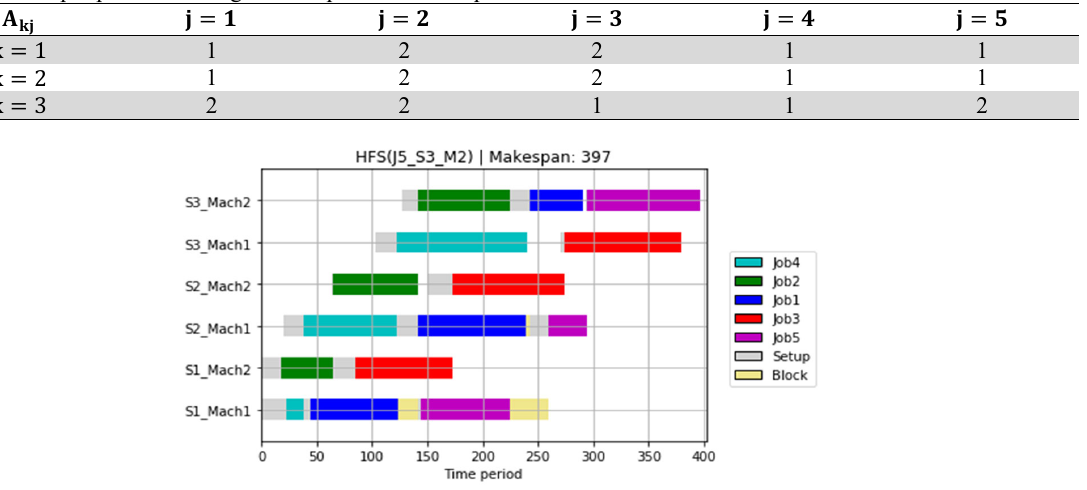
Fig. 1. Gantt chart for the presented